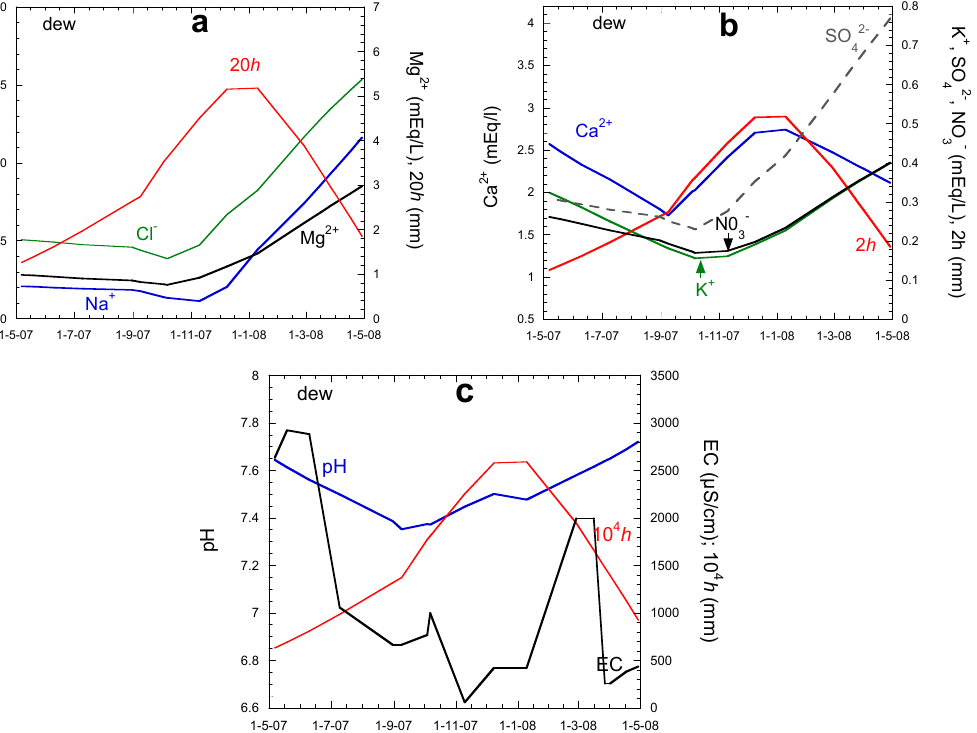
Figure 17. Evolution of dew ions. ( a ) Comparative evolution of sea ions’ concentrations and dew volume per unit area h (mm). ( b ) Same as ( a ) but with continental ions. ( c ) Evolution of electric conductivity EC (µS·cm − 1 ), pH and h (mm). All curves are smoothed fit of single values. One expects for the future evolution described by the scenarios RCP 2.6 and RCP 8.5